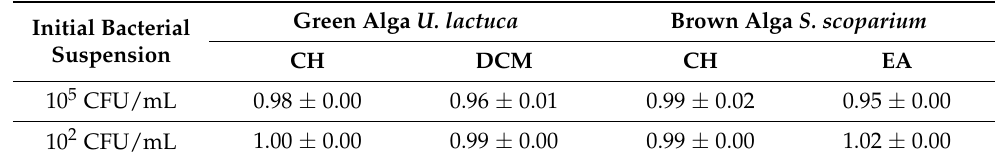
Table 1. Evaluation of the potential bactericidal activity of the selected extracts (final concentration: 50.0 µ g/mL) on S. aureus (10 5 CFU/mL or 10 2 CFU/mL). The number of planktonic cells was measured after 24 h of incubation at 37 ◦ C under agitation. Results are expressed as ratio between the number of bacteria (log CFU/mL) in sample tube and those in the control tube. Initial